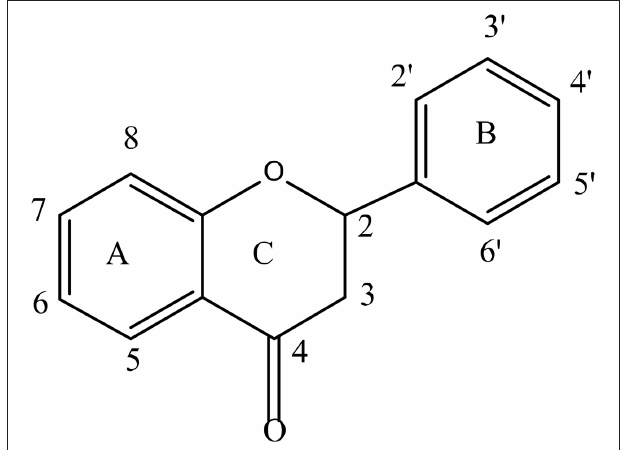
FIGURE 2 | The basic structure of